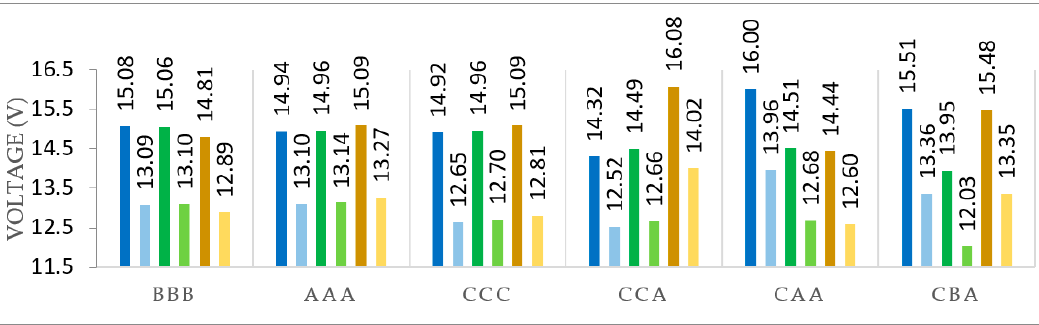
Figure 11. Voltage balance in CSCs depending on association at operating point N° 1 in ISOS config.